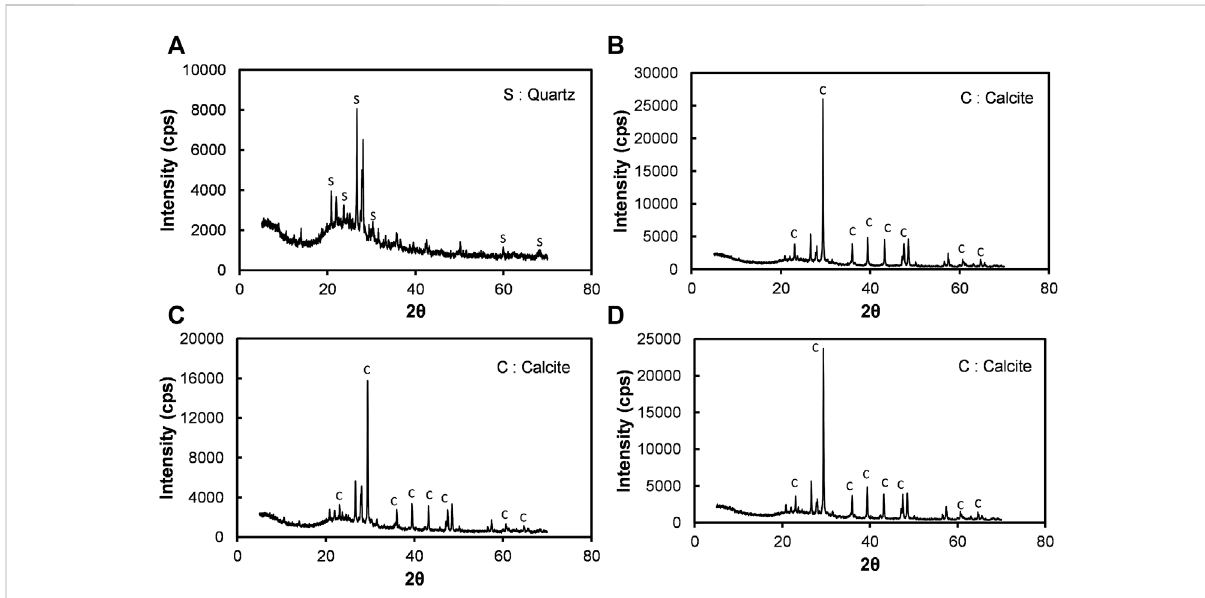
FIGURE 13 XRD analysis results of (A) untreated, (B) MICP treated, (C) B-EICP treated (25 ° C)and (D) B-EICP treated (15 ° C) silty sand (Watsu).